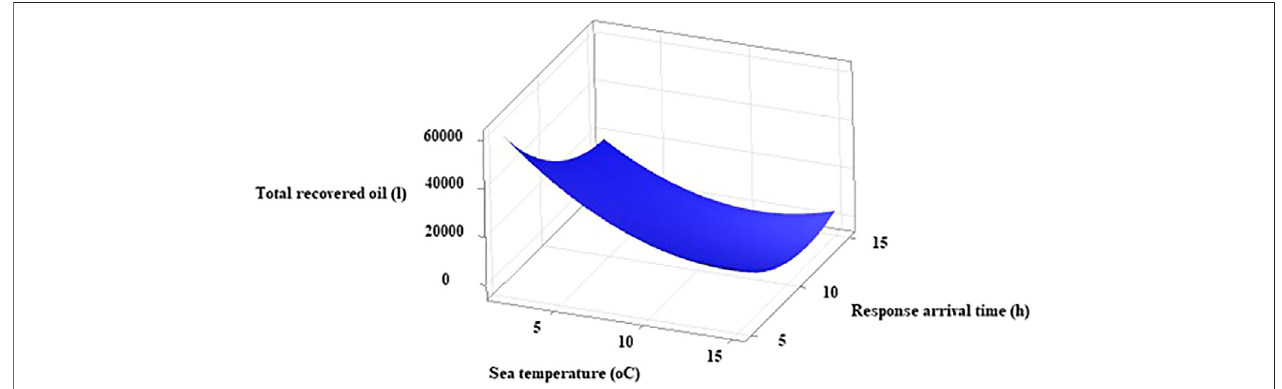
FIGURE3 | A contour plot for the estimationoftotal recovered oil (L) based on the interactionof sea temperature ( ° C) and responsearrival time (h) in the Bella Bella oil spill.